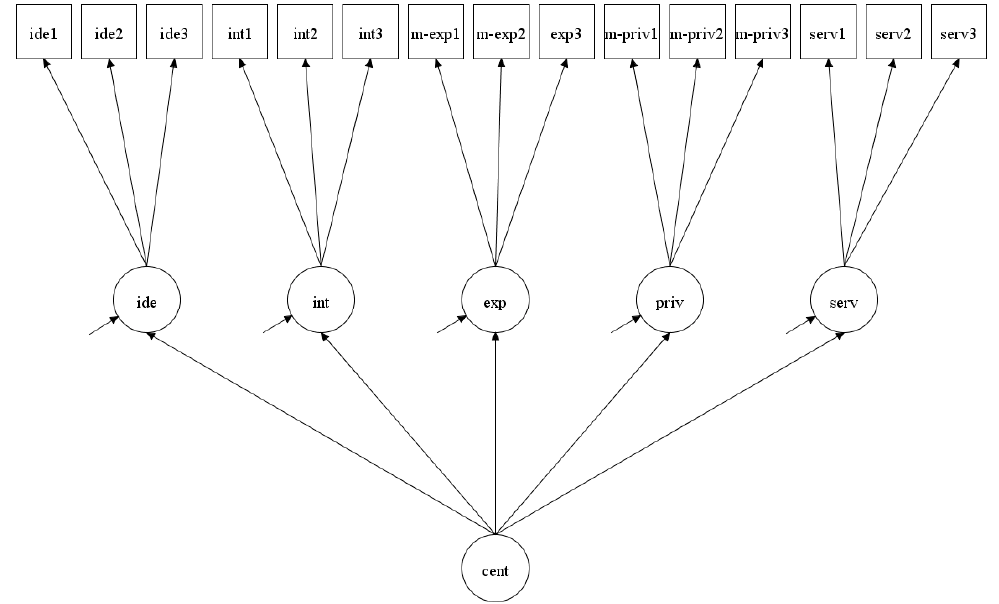
Figure 6. The confirmatory factor analysis model for the CRSi-20. int = intellect; ide = ideology; serv = public practice; priv = private practice; exp = experience; m = this prefix means that out of two items, only the one with the higher value for this core dimension is proceeded in the analysis. The number after the item name indicates the position of the item within the core dimension items. Squares depict manifest and circles latent variables. Residual arrows are not shown for the manifest variables. Residuals for the latent variables are shown as arrows starting in blank space.